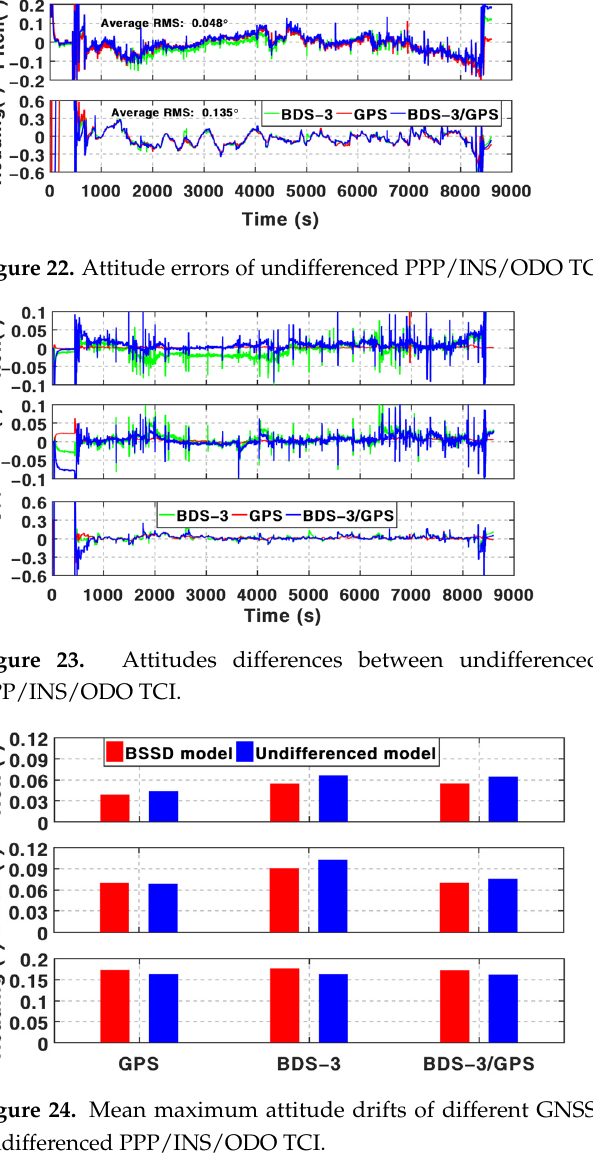
differenced PPP/INS/ODO TCI, the mean position RMS of BSSD PPP/INS/ODO TCI is improved by 7.71%, 3.09%, and 0.27%. The mean maximum drifts can be reduced from 82.38 cm, 50.66 cm, and 52.30 cm to 66.29 cm, 45.84 cm, and 49.17 cm by utilizing the BSSD model. For attitude determination, the mean attitude RMS of PPP/INS TCI is 0.025 ° , 0.049 ° , and 0.184 ° in three components. The addition of an odometer brings a 25% improve- ment to the RMS of heading angles and reduces the mean maximum drifts from 0.313 ° to 0.174 ° . The results of the other two components are comparable. Moreover, the accu- racy of PPP/INS/ODO TCI with and without the BSSD model is similar to each other.